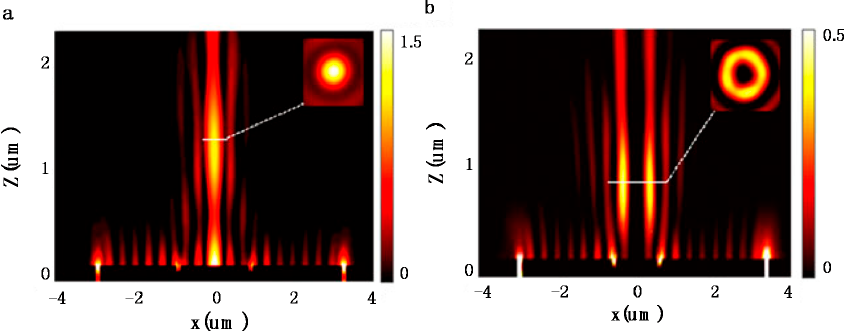
Figure 9. The simulated | E | 2 distributions in the x - z -plane for the left-hand spiral plasmonic lens under RCP incidence ( a ) and LCP incidence ( b ). Reproduced with permission from [48]. Copyright Springer, 2011.